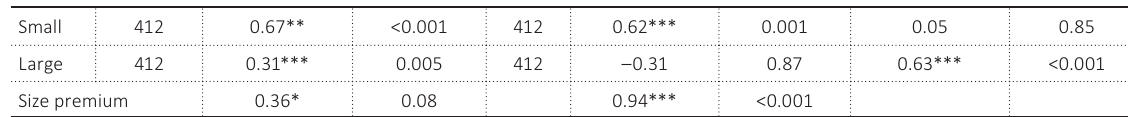
Panel B. CAR for chaotic